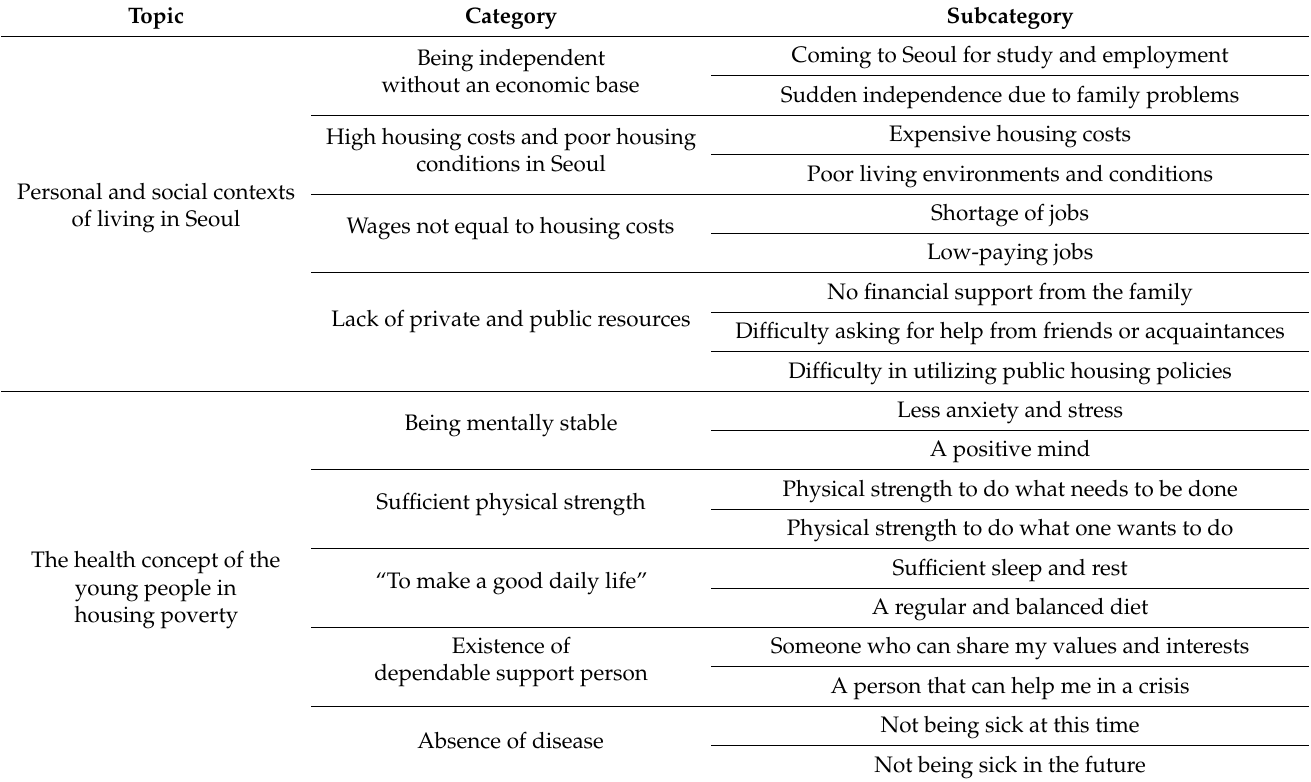
Table 4. Results by category and